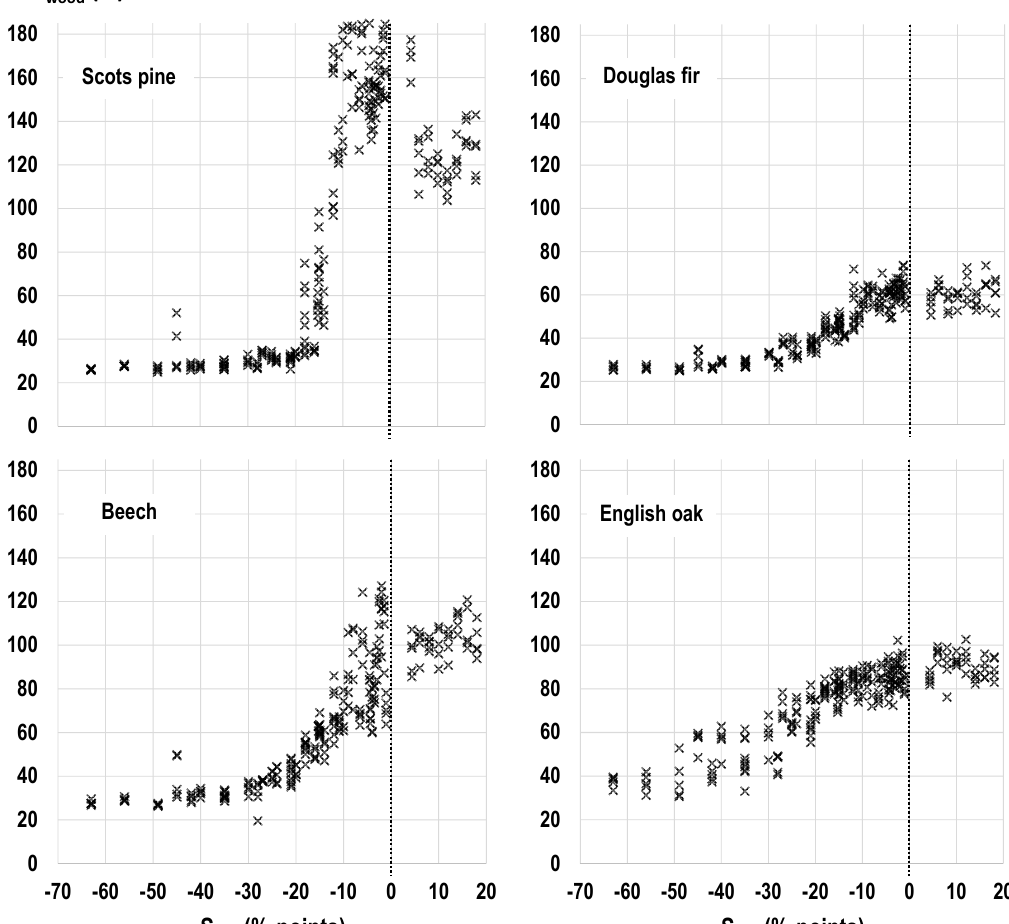
Figure 5. The interrelationship between the distance to water saturation of the soil substrates (S soil ) and the wood moisture content (MC wood ).